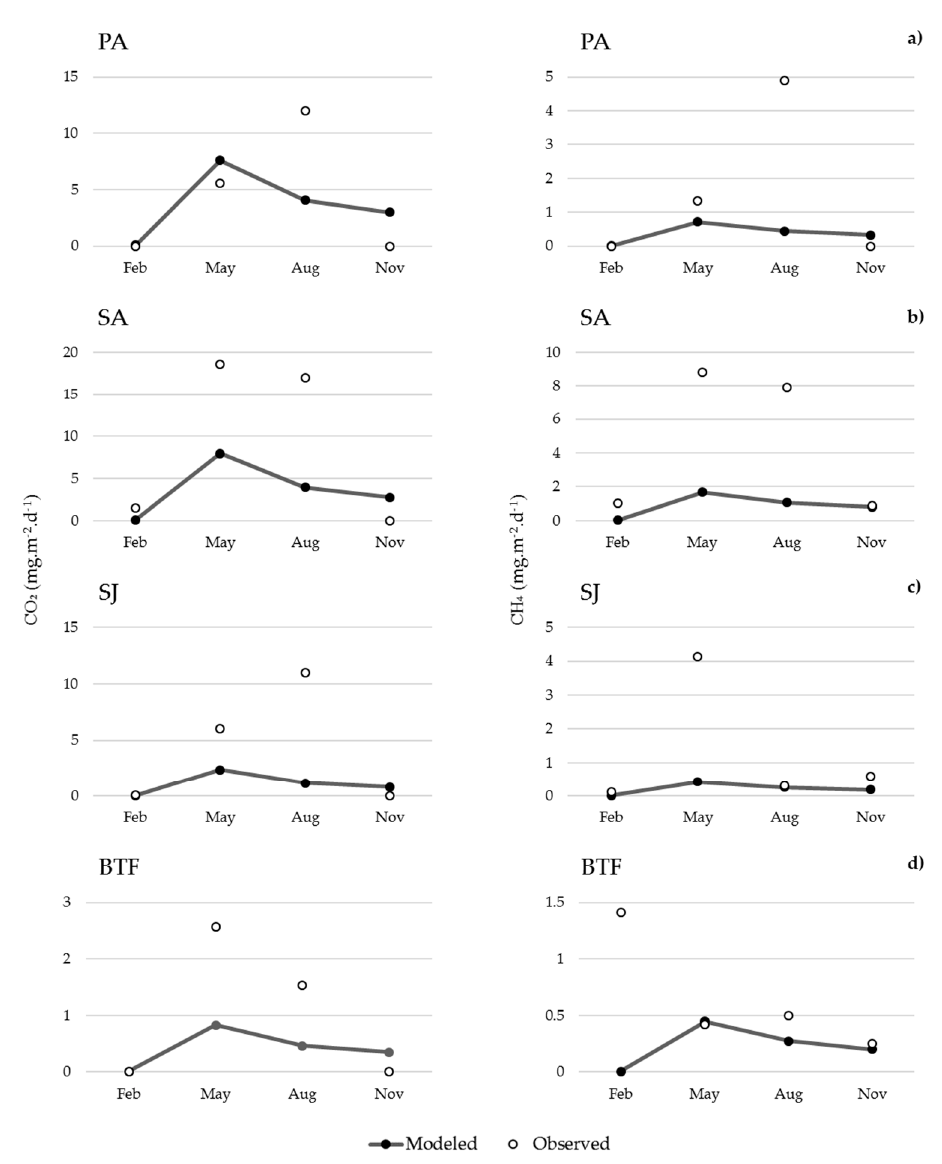
Figure 6. Comparison of simulated and observed CO 2 and CH 4 emissions (25 cm depth) during 2019 at four sites: ( a ) PA, ( b ) SA, ( c ) SJ and ( d ) BTF.